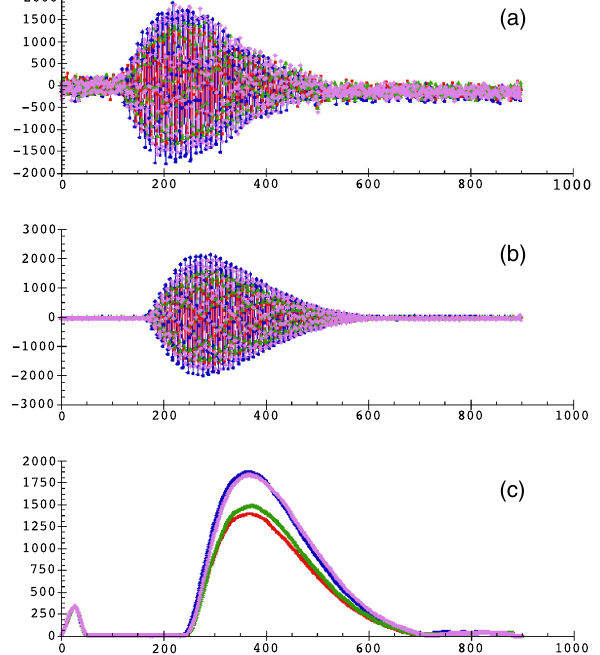
FIG. 32. Raw BPM electronics waveforms (ADC raw value versus sample number), sampled by the DRS4 chip at 5 GSample/ s (a). The same waveforms after offset gain and time-nonlinearity correction, performed by the FPGA for each sample individually (b). Envelopes of the four BPM electronics signals as calculated by the FPGA (signal amplitude versus sample number) (c). The additional delay is due to digital